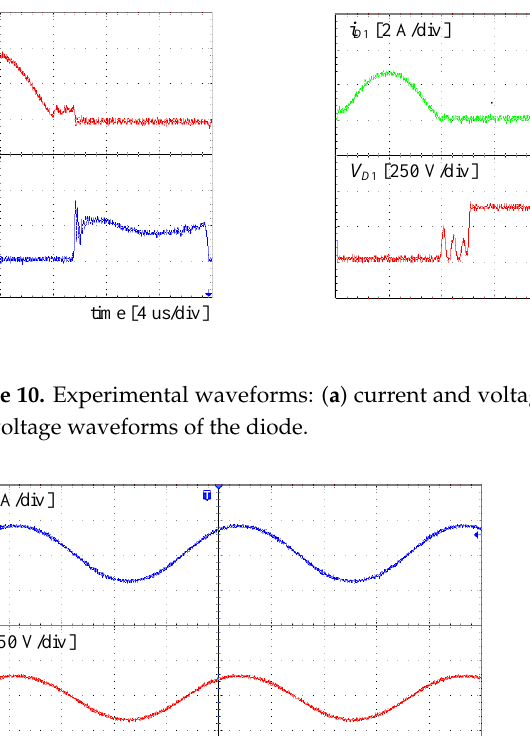
Figure 9. The experimental setup of a 500-W prototype converter.